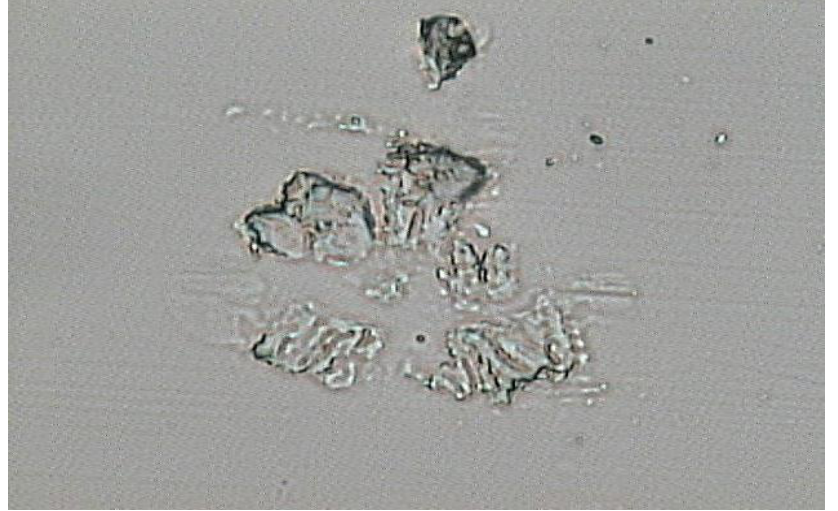
Figure 4. Microscopic photograph of the cell morphologies of the microalgae irradiated by microwave at an input energy of 6500 J associated with a direct solvent mixture of n -hexane/isopropanol (2/1 v / v ), at a magnification of